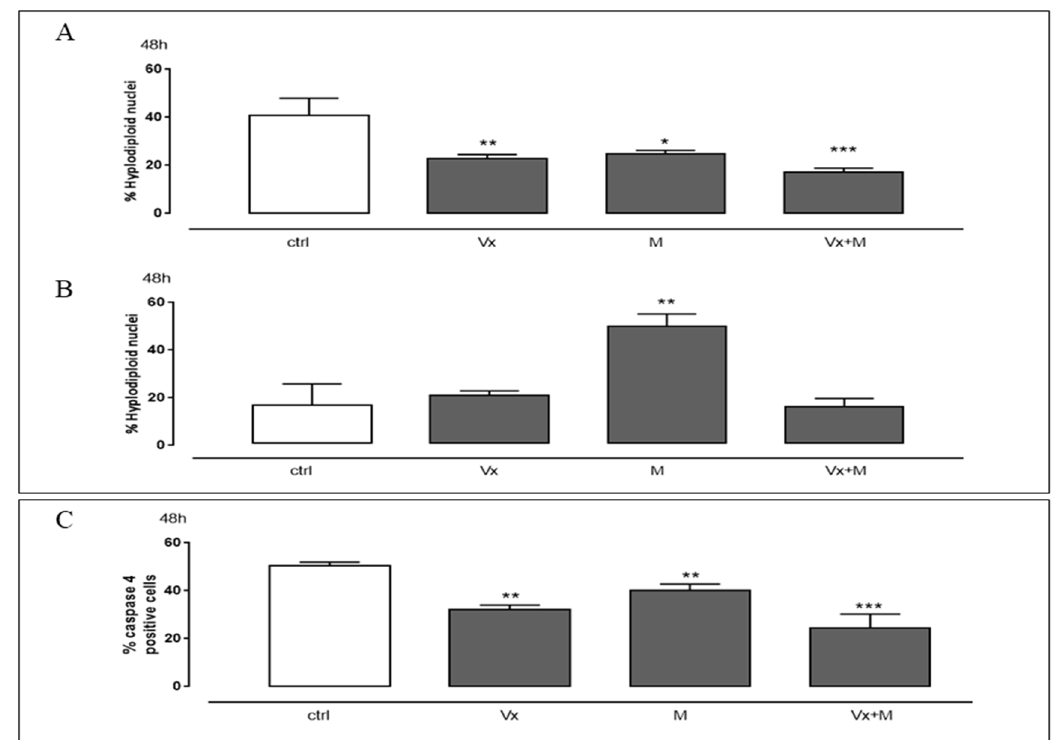
Figure 5. The “corrector” of CFTR and the quinolizidine alkaloid interfere with the cell death. Vx-809 (2 µM) and Matrine (300 µM) were administered for 48h in A549 ∆ ( A ) and A549wt ( B ). Then, cells were stained by propidium iodide and fluorescence of individual nuclei was measured by flow cytometry. Results are expressed as mean ± S.E.M. of percentage of hypodiploid nuclei from at least three independent experiments each performed in duplicate. Data were analyzed by Mann–Whitney U test. * p < 0.5, ** p < 0.05, and *** p < 0.001vs non-treated cells. Panel ( C ) shows caspase 4 content detected by flow cytometry analysis. Data were expressed as mean ± S.E.M. of percentage of caspase 4 positive cells from at least three independent experiments each performed in duplicate. Data were analyzed by Mann–Whitney U test. ** P < 0.05 and *** p < 0.001 vs. non-treated cells.